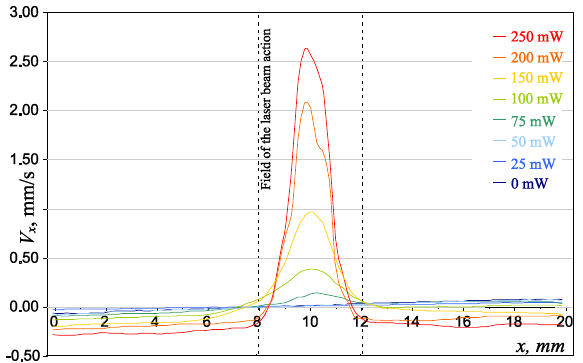
Figure 3. The velocity distribution profile for MF particles in the monolayer dust structure under the action of the pushing laser with power values of W = 0, 25, 50, 75, 100, 150, 200, and 250 mW.